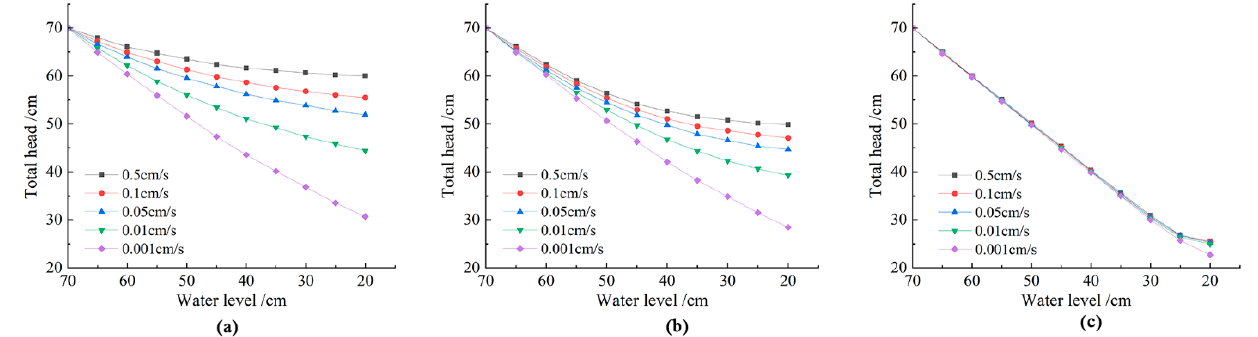
Figure 8. Comparison of water levels inside and outside of the silt slope with different deceleration slopes: ( a ) x = 230 cm; ( b ) x = 165 cm; and ( c ) x = 100 cm.